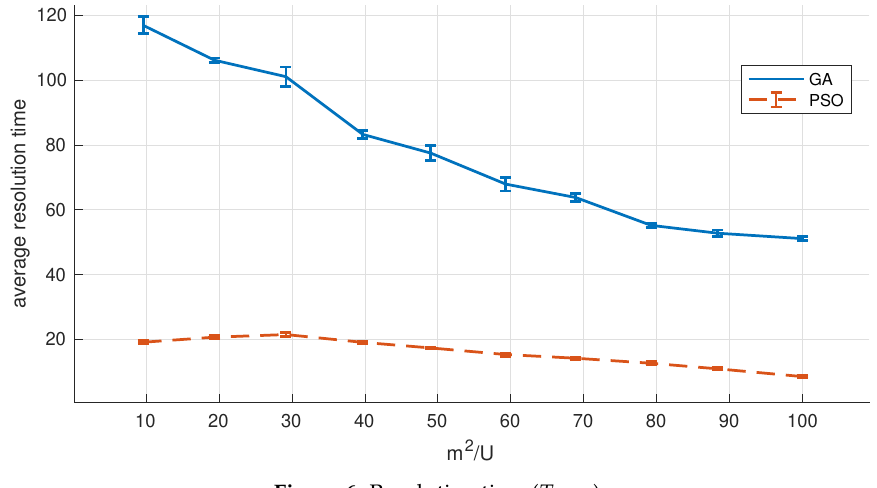
Figure 6. Resolution time ( T solve